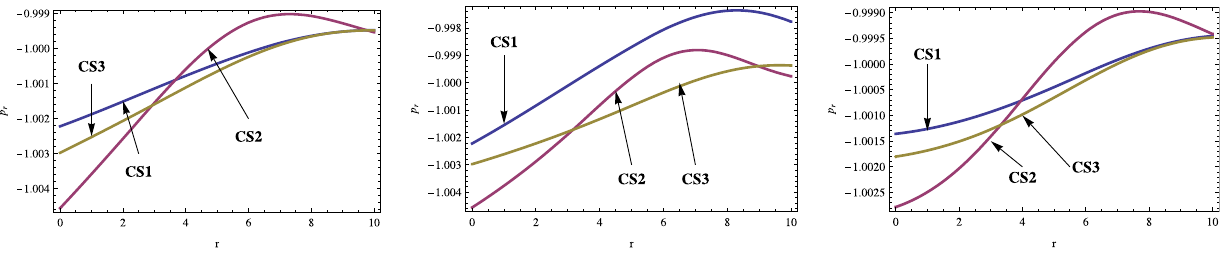
Fig. 2 Variations of radial pressure p r ( MeV / f m 3 ) versus r ( km ) with the numerical values of A , B and C from Tables 2, 3 and 4